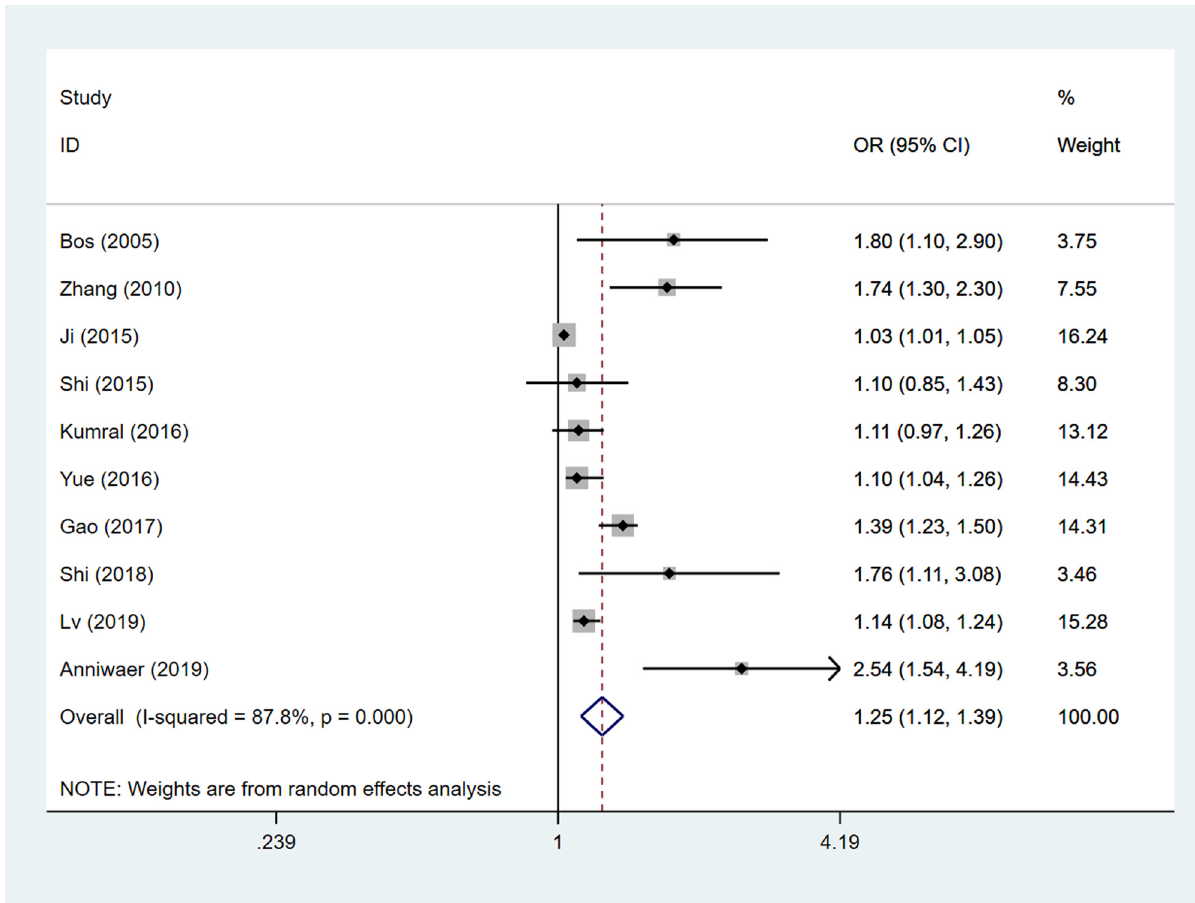
Figure 5: Forest plots showing the e ff ect of elevated Hcy levels on recurrent strokes. The high Hcy levels increased the risk of recurrent stroke ( OR = 1.25 )